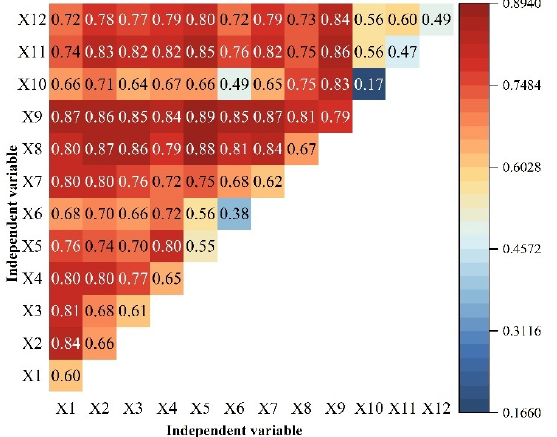
Figure 9. Interaction detector results.